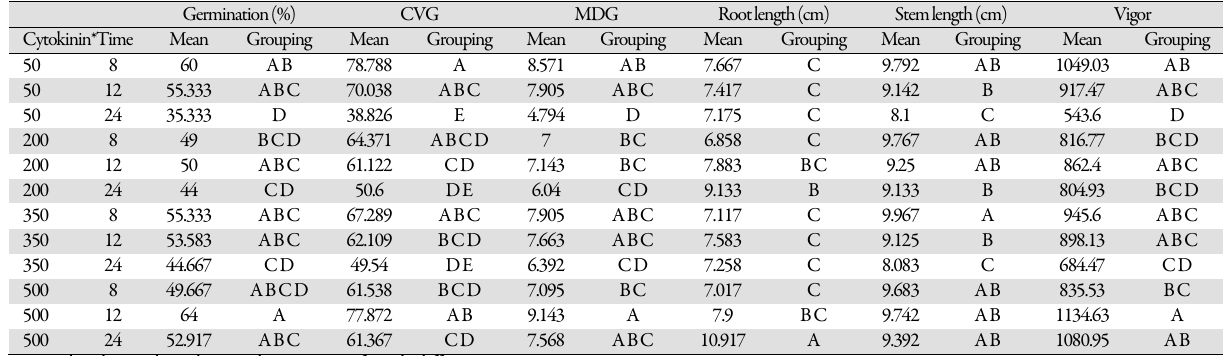
Means that do not share the same letter are significantly different. Table 2. Mean comparison of priming duration and cytokinin concentrations on germination properties of Silybum marianum Germination (%)